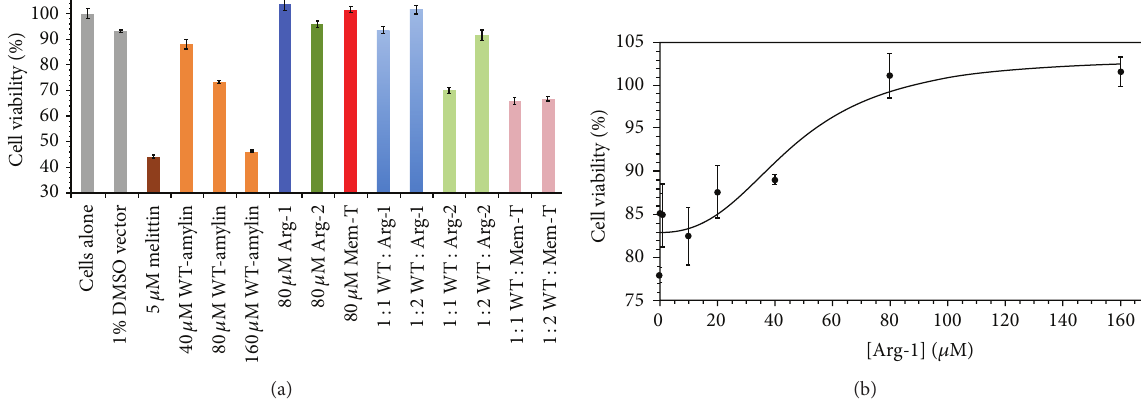
Figure 10: Effects of charge-based inhibitors on amylin cytotoxicity. (a) Cytotoxicity of WT-amylin and analogs towards a MIN6 mouse insulinoma cell model of 𝛽 -pancreatic cells [18]. Gray, cells-only, defined as 100% cell viability and 1% DMSO vector used for all experiments except the first; brown, positive melittin control; orange, WT-amylin at different concentrations; blue, green, red-cells challenged with 80 𝜇 M Arg-1, Arg-2, Mem-T respectively; light blue, green, red-cells challenged with 80 𝜇 M WT-amylin and the indicated molar ratios of the respective inhibitors. (b) Viability of MIN6 cells challenged with 80 𝜇 M WT-amylin as a function of Arg-1 concentration. The cell viability data were fit to an IC 50 value of 47±17 𝜇 M Arg-1. All data points are averages from measurements performed in triplicate and the uncertainties are the associated